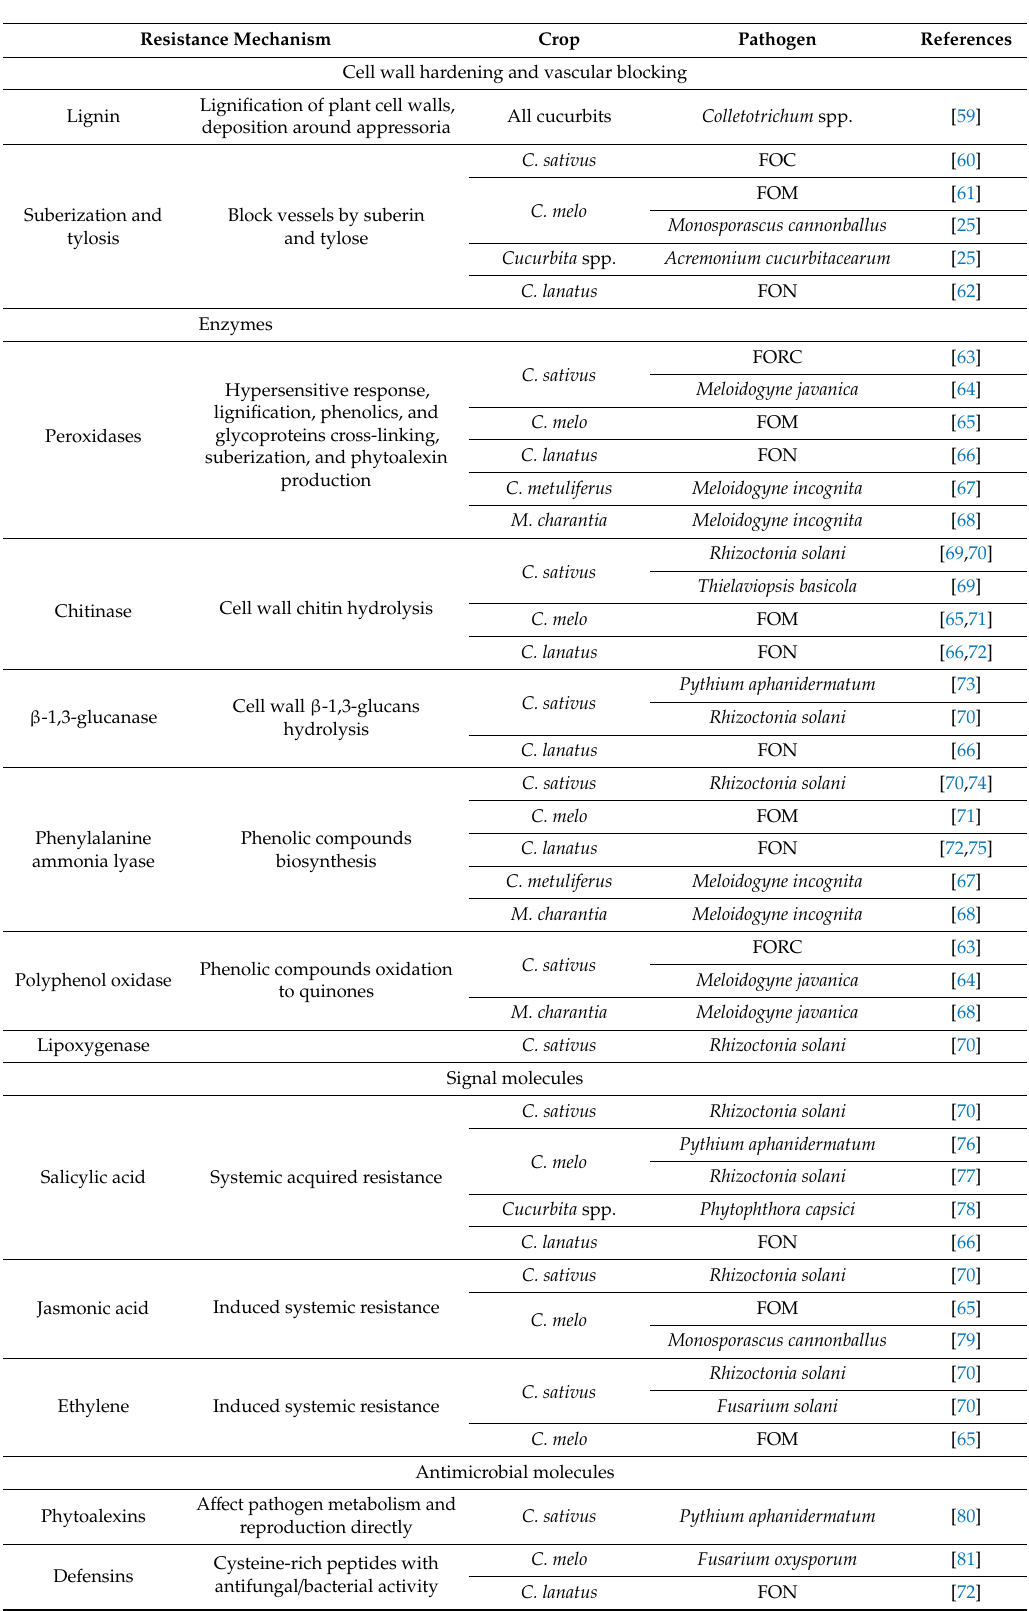
Table 1. Main pathogenesis-related proteins and molecules involved in resistance against soil-borne diseases in